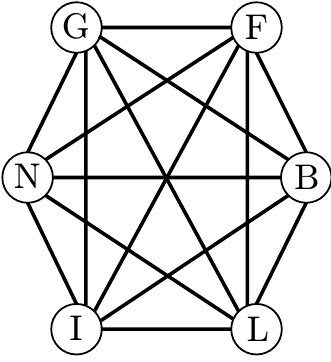
Figure 2. Full graph g N with N = { G,F,I,N,B,L }